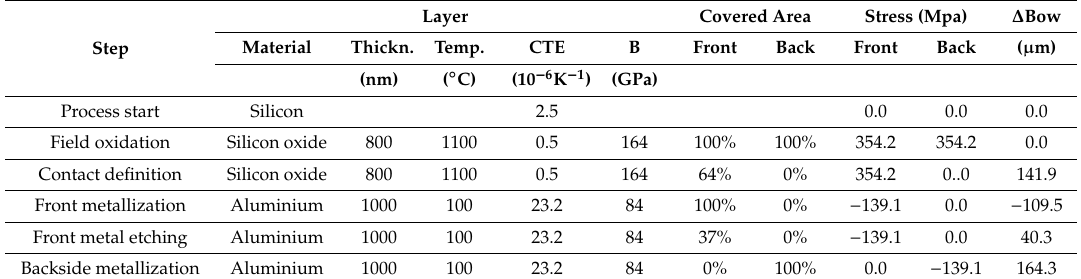
Table 2. Toy model for bow during the fabrication of a planar pixel detector (wafer thickness: 230 µ